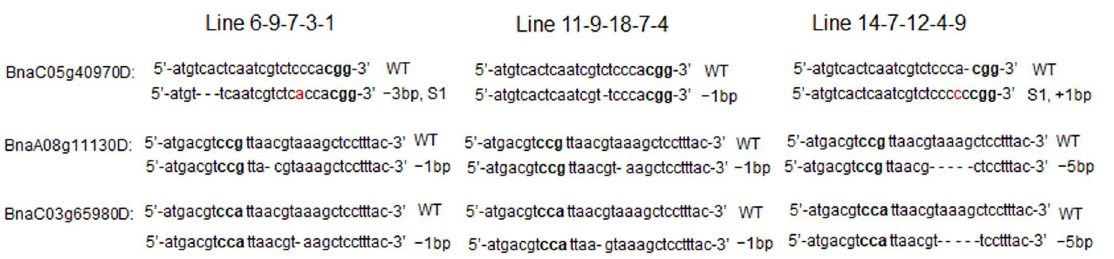
Figure 2. Mutations in the target region of BnFAD2 and BnFAE1 in homozygous mutants. Substitu- tions, insertions and deletions are indicated in red fonts, “+” and “ − ”, respectively. S1 indicates a nucleotide substitution. PAM was highlighted in bold fonts. Table 3. Relative FA content in seeds of the edited lines.